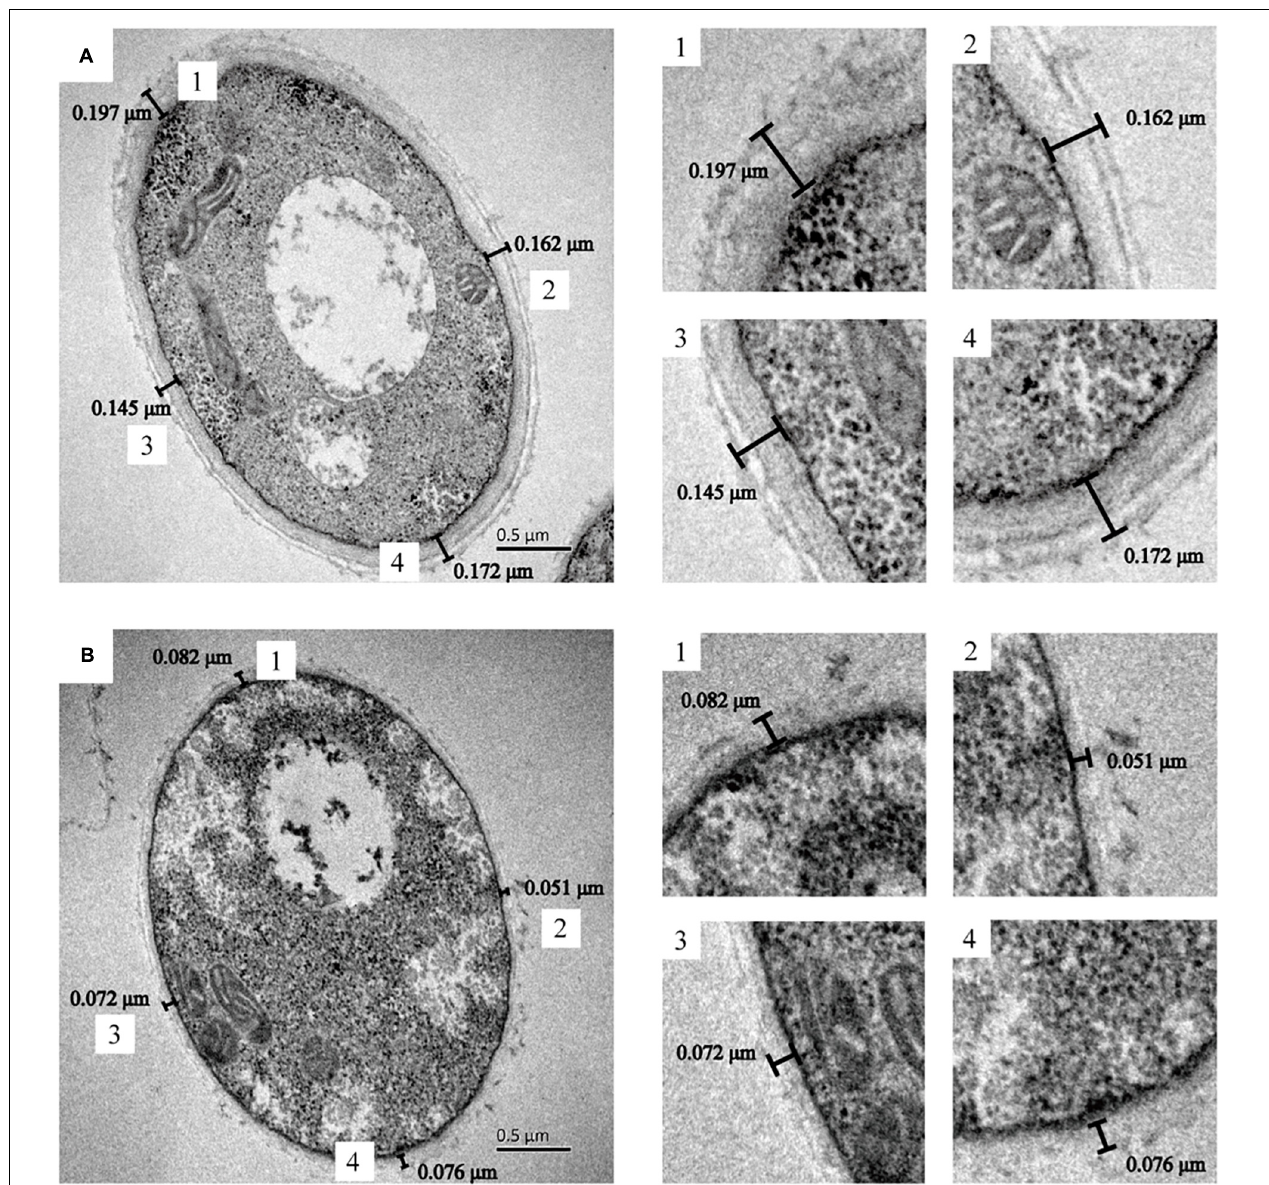
FIGURE 5 | G. lucidum cultured in several conditions. TEM pictures obtained after chemical fixation. (A) G. lucidum was cultivated at 30 ◦ C on a rotary shaker at 150 rpm. (B) G. lucidum was cultivated in a medium containing 0.4 g/L L-phenylalanine, added at 24 h.